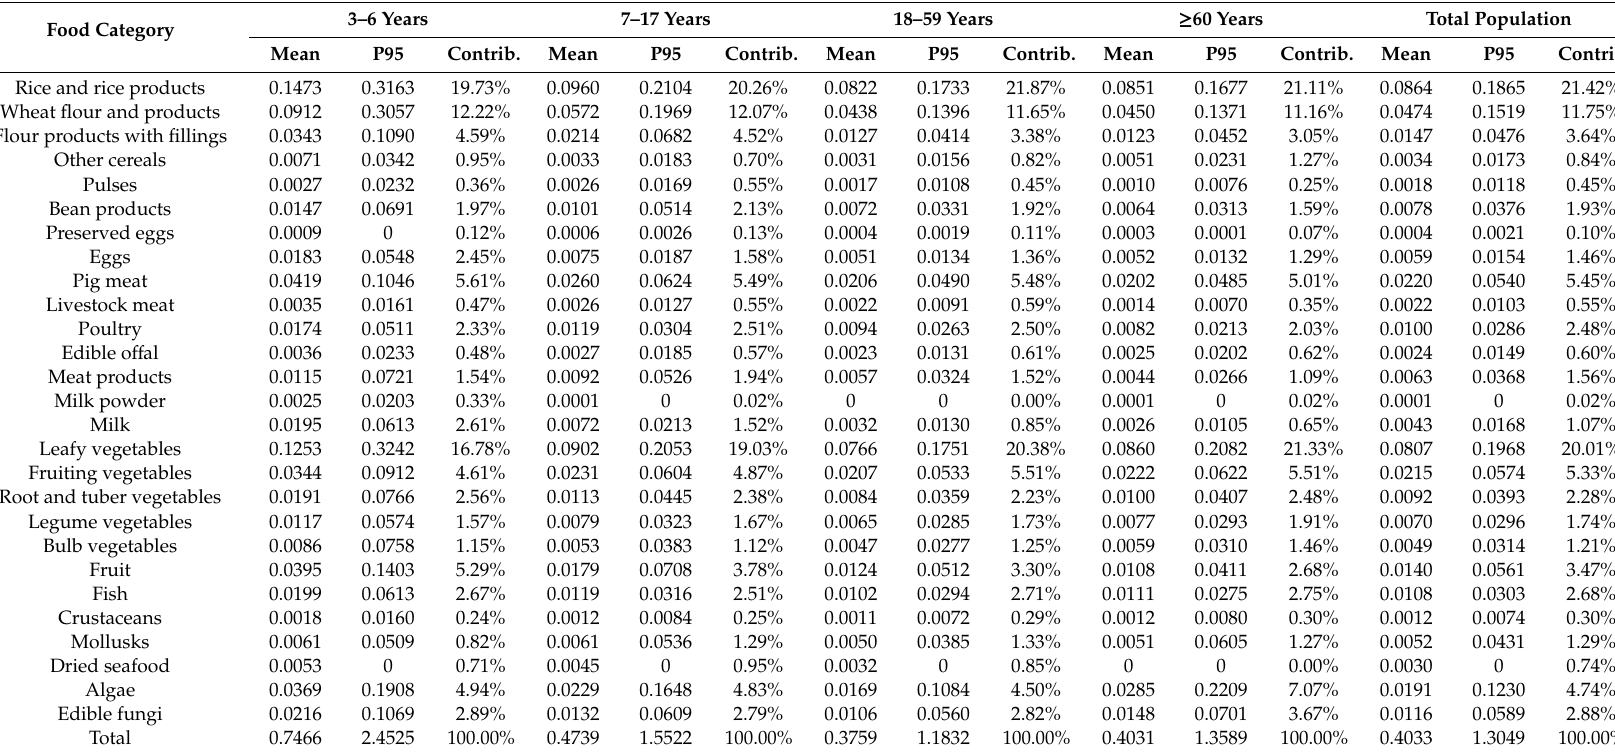
Table 3. Detailed estimated dietary exposure (mean and 95th percentile) to lead among Guangzhou residents ( µ g / kg bw /